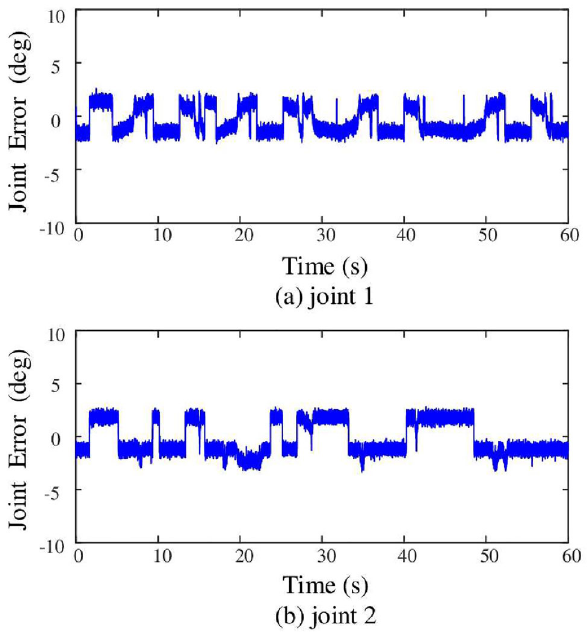
Fig. 8 Joint position error curves under existing decentralized robust control method in Fig. 15, using the proposed control method, the instanta- neous growth of control torque is kept within the safe range.